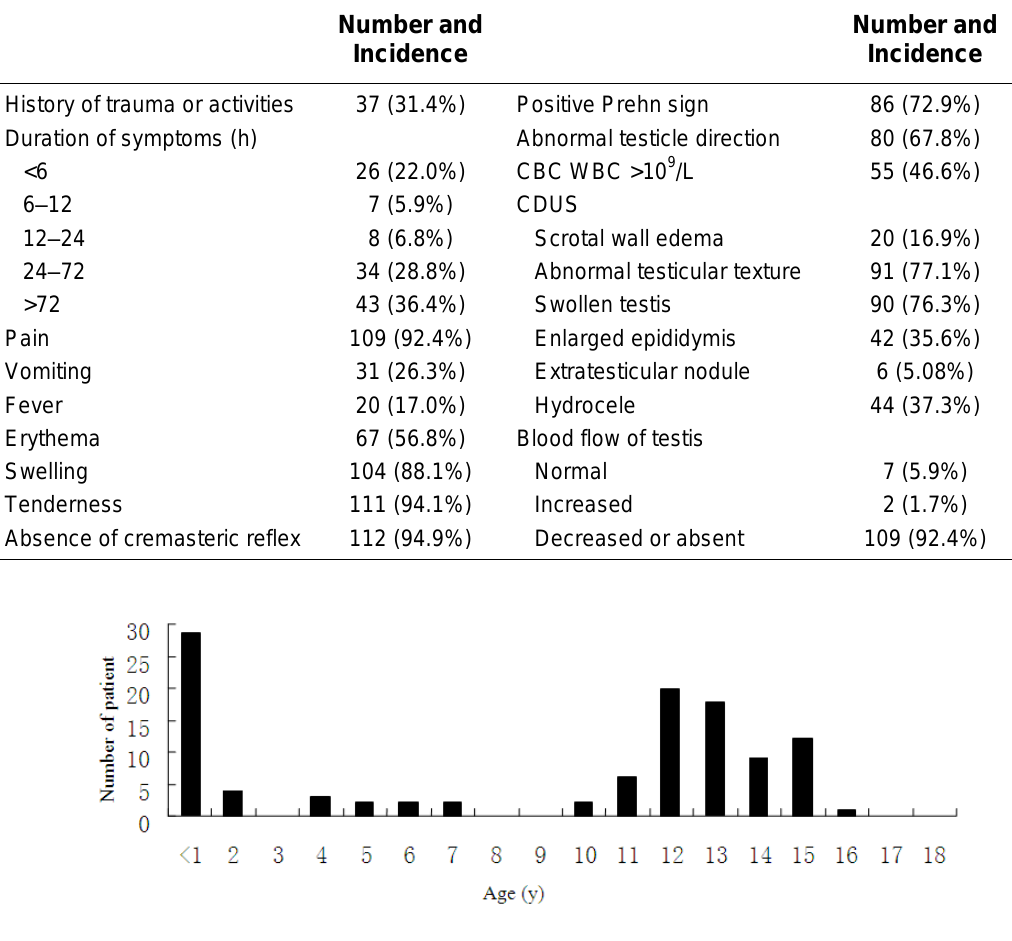
FIGURE 1. Age distribution of boys with